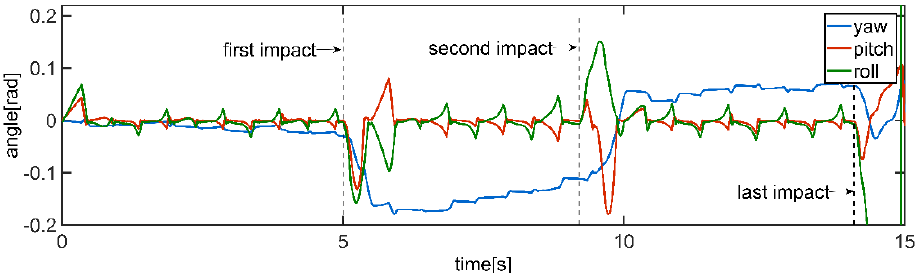
Figure 25. Posture angles of the principal-axes coordinate system.